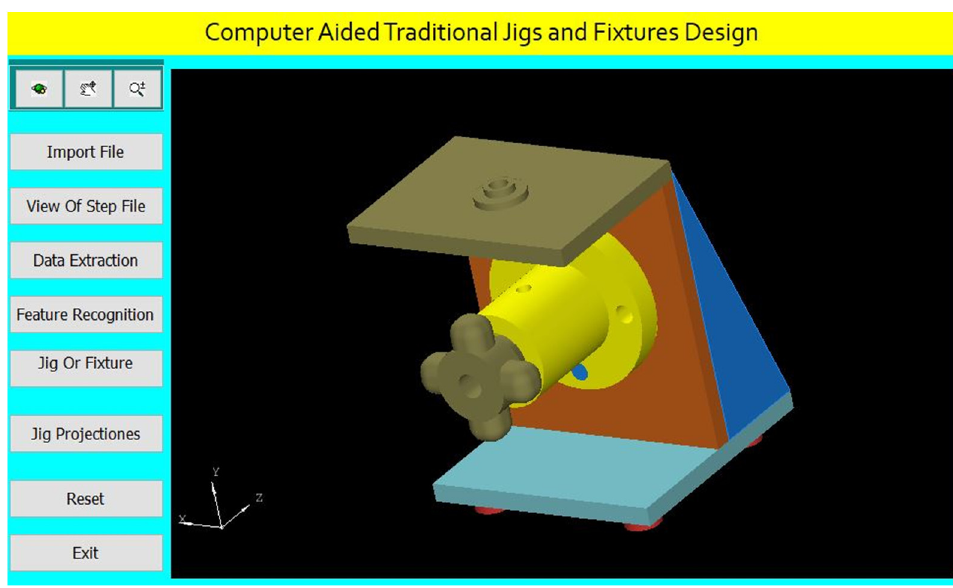
Figure 42. Computer-aided design of a jig for the cylindrical part.